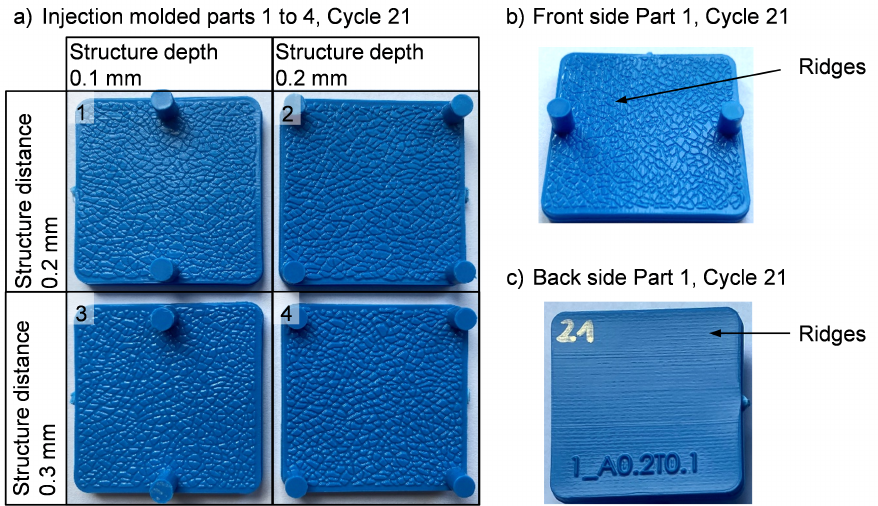
Figure 6. ( a ) Parts 1 to 4 of the 21st injection molding cycle, ( b ) Ridges within the grain structure on part 1, ( c ) Ridges on the back of part